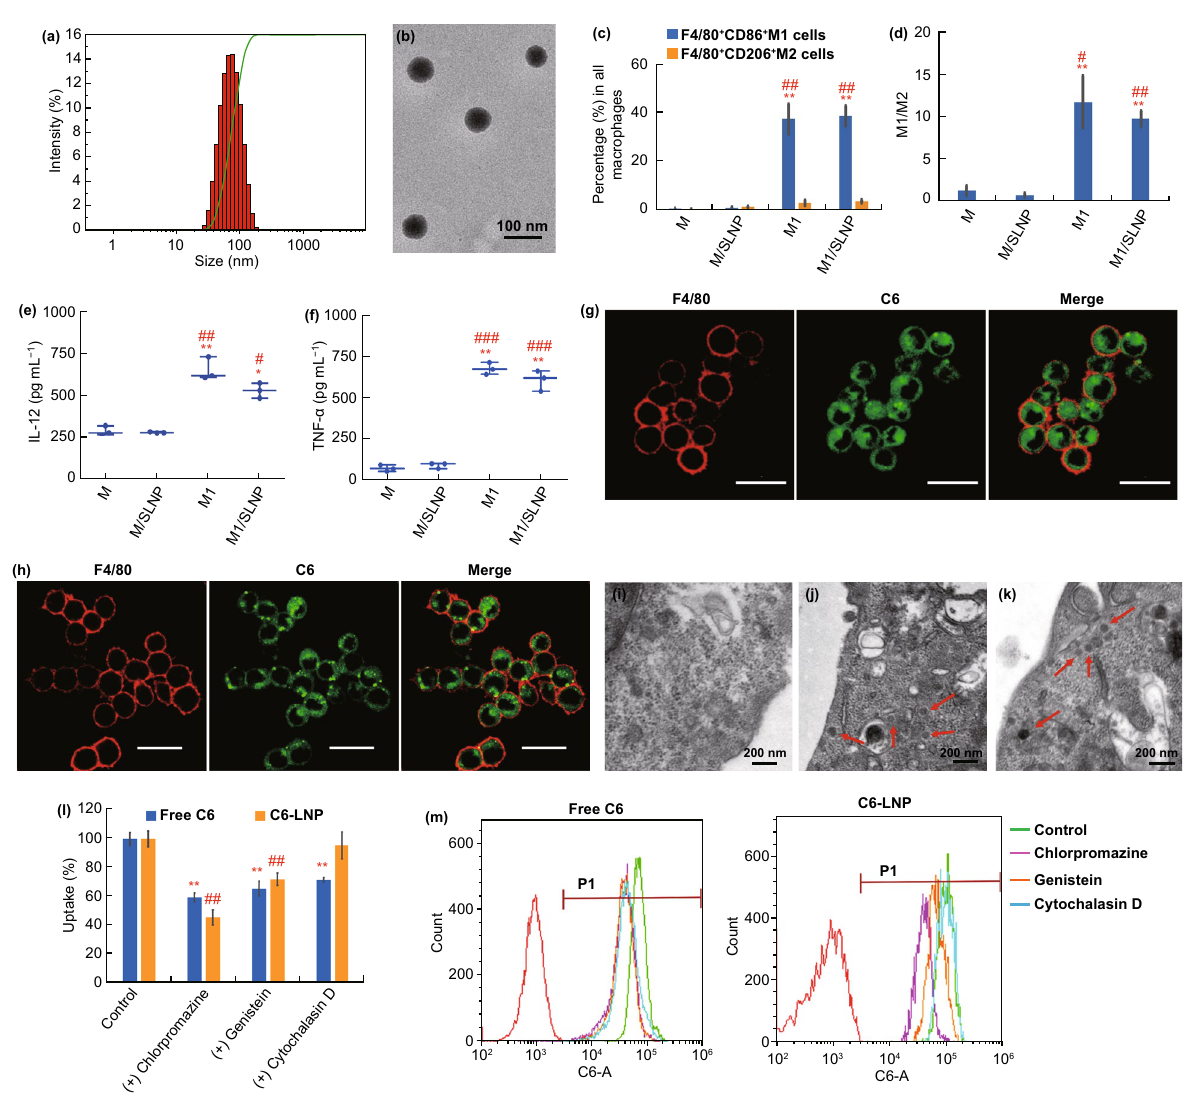
Fig. 1 Characterization of M1/SLNP. a Particle size of SLNP. b TEM image of SLNP. c FCM analysis of phenotypes of M, M/SLNP, M1, and M1/SLNP in vitro . “Percentage (%)” in the Y-axis represents the percentage of M1-type macrophages (F4/80 + CD86 + M1 cells) in all macrophages or the percentage of M2-type macrophages (F4/80 + CD206 + M2 cells) in all macrophages. d Ratio of M1/M2 by FCM analy- sis. ** p < 0.01, compared with M; # p < 0.05, ## p < 0.01, compared with M/SLNP. e–f Levels of e IL-12 and f TNF-α in vitro. ### p < 0.001, ## p < 0.01, # p < 0.05, compared with M/SLNP; ** p < 0.01, * p < 0.05, compared with M. CLSM images of g M/C6-LNP and h M1/C6-LNP. Scale bar: 20 μm. TEM images of i macrophages, j M/SLNP , and k M1/SLNP. Red arrow indicated SLNP. Scale bar: 200 nm. The endocytic pathway of SF and SLNP in macrophages: l FCM histogram profiles of fluorescence intensity; m FCM analysis. n = 3, ** p < 0.01, ## p < 0.01, compared with